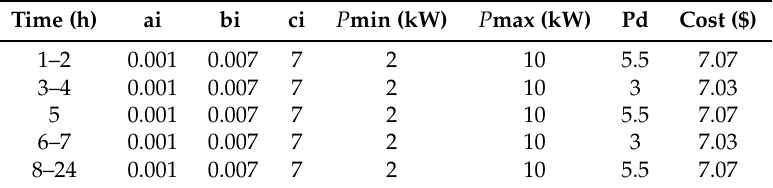
Figure 18. Hourly electricity cost of r , el and iel appliances. Table 7. Generator output to serve r